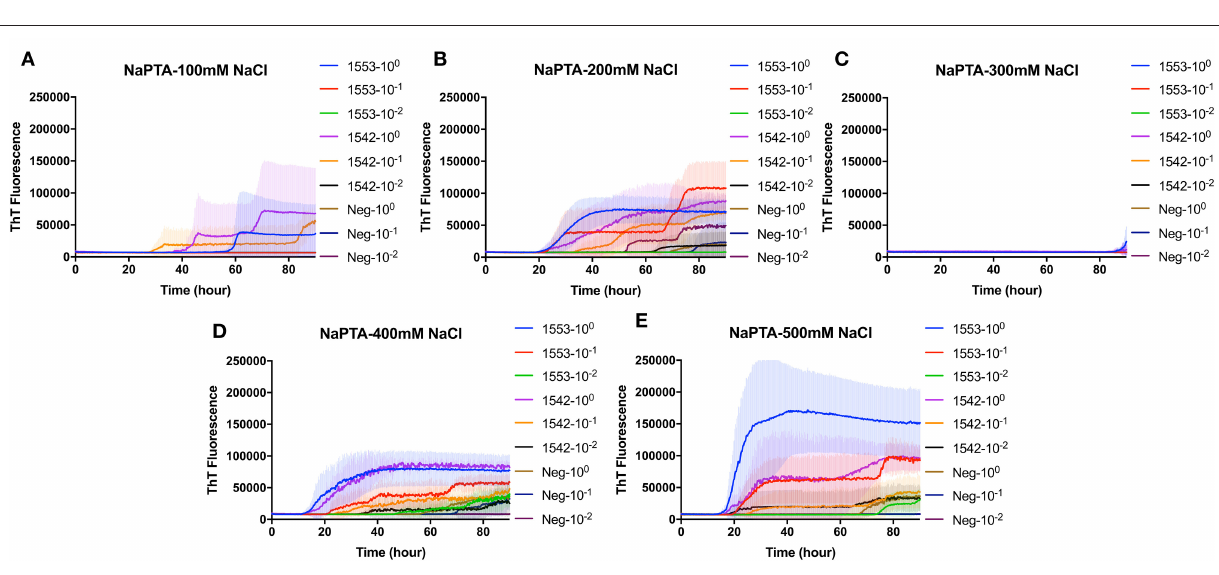
All other reagents in the protocol were also increased by